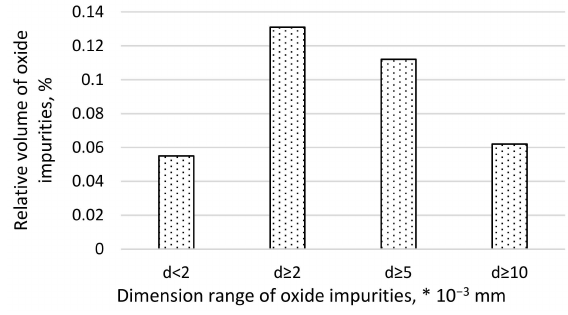
Figure 2. Dimensional structure of steel